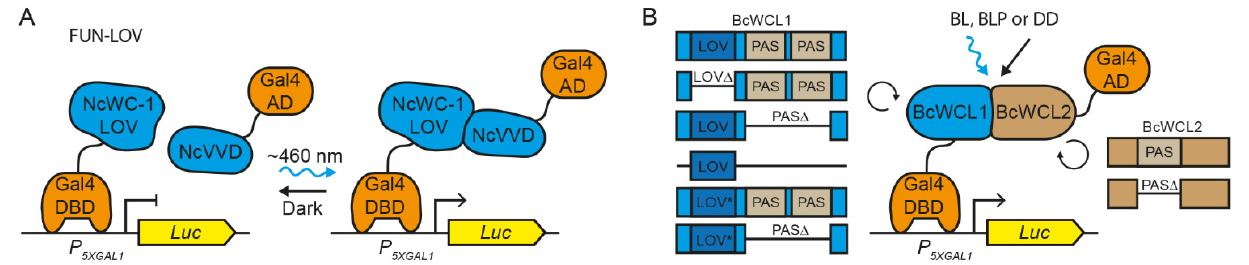
Figure 1. Protein–protein interaction assays performed for B. cinerea WCC proteins. ( A ) The FUN- LOV optogenetic switch architecture [32]. This system enables light-controlled gene expression in yeast through protein–protein interaction of the LOV domain of WC-1 and the photoreceptor VVD from N. crassa . ( B ) Light-modulated protein–protein interaction assay used in this work. The Gal4 DNA-binding domain (DBD) was linked to BcWCL1 or its variants with LOV domain deletion (BcWCL1 LOV ∆ ), PAS domains deletion (BcWCL1 PAS ∆ ), or a protein region containing the LOV domain (BcWCL1 LOV ) as a single module. The LOV* versions of BcWCL1 and BcWCL1 PAS ∆ proteins carry the C414S mutation. Similarly, the Gal4 transactivation domain (AD) was tied to the BcWCL2 or its variant with PAS domain deletion (BcWCL2 PAS ∆ ). Abbreviations: DD, constant darkness; BL, con- stant blue light; BLP, blue-light pulse of 2 h duration; Luc, luciferase reporter gene; 5XGAL1 , syn- thetic GAL1 promoter.